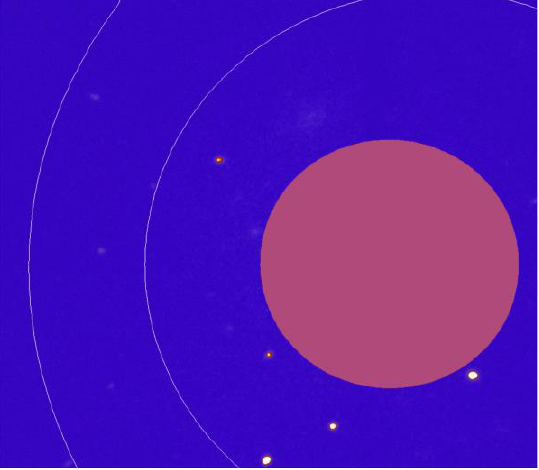
Figure 6. ROI of the diffraction image to digitalize the diffraction area border lined by the primary circle.